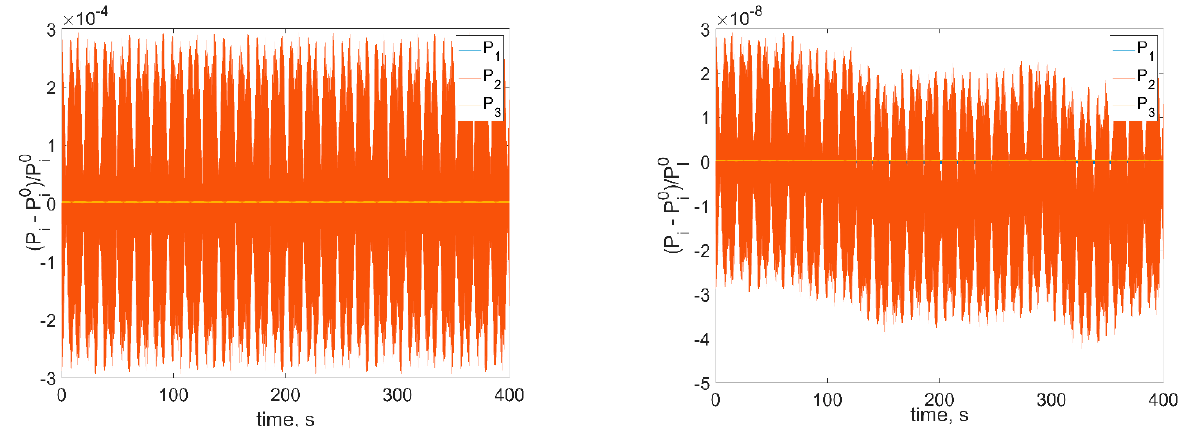
Figure 3. Relative variation of the total momentum ( left ) h = 10 − 2 s and ( right ) h = 10 − 3 s).